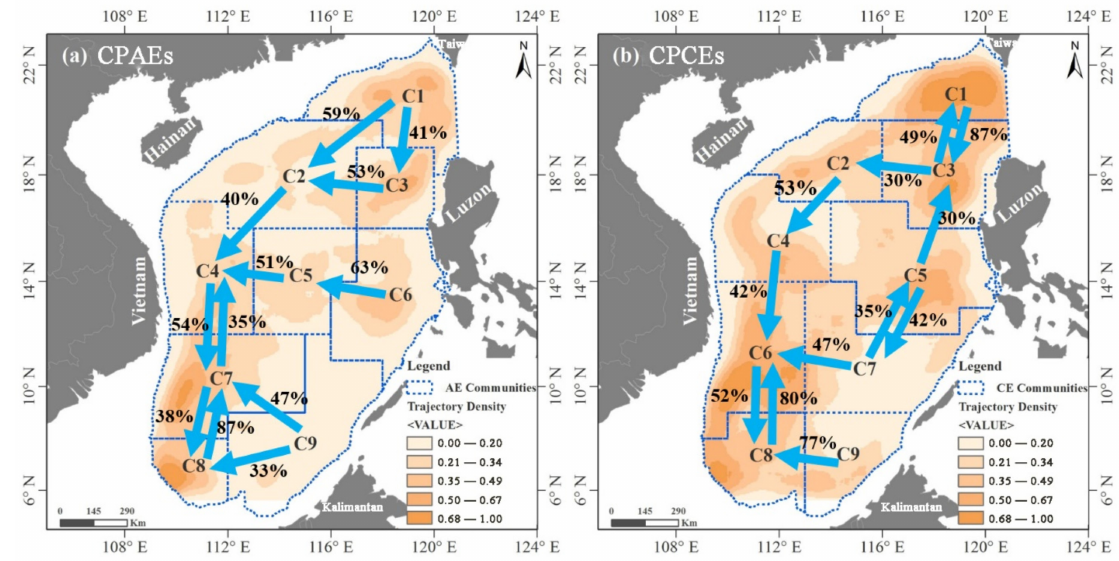
Figure 11. The community division results of CPAEs ( a ) and CPCEs ( b ). The numbers show the percentages of the eddies that migrate along with the dominate flow directions, which are shown by the blue arrows.